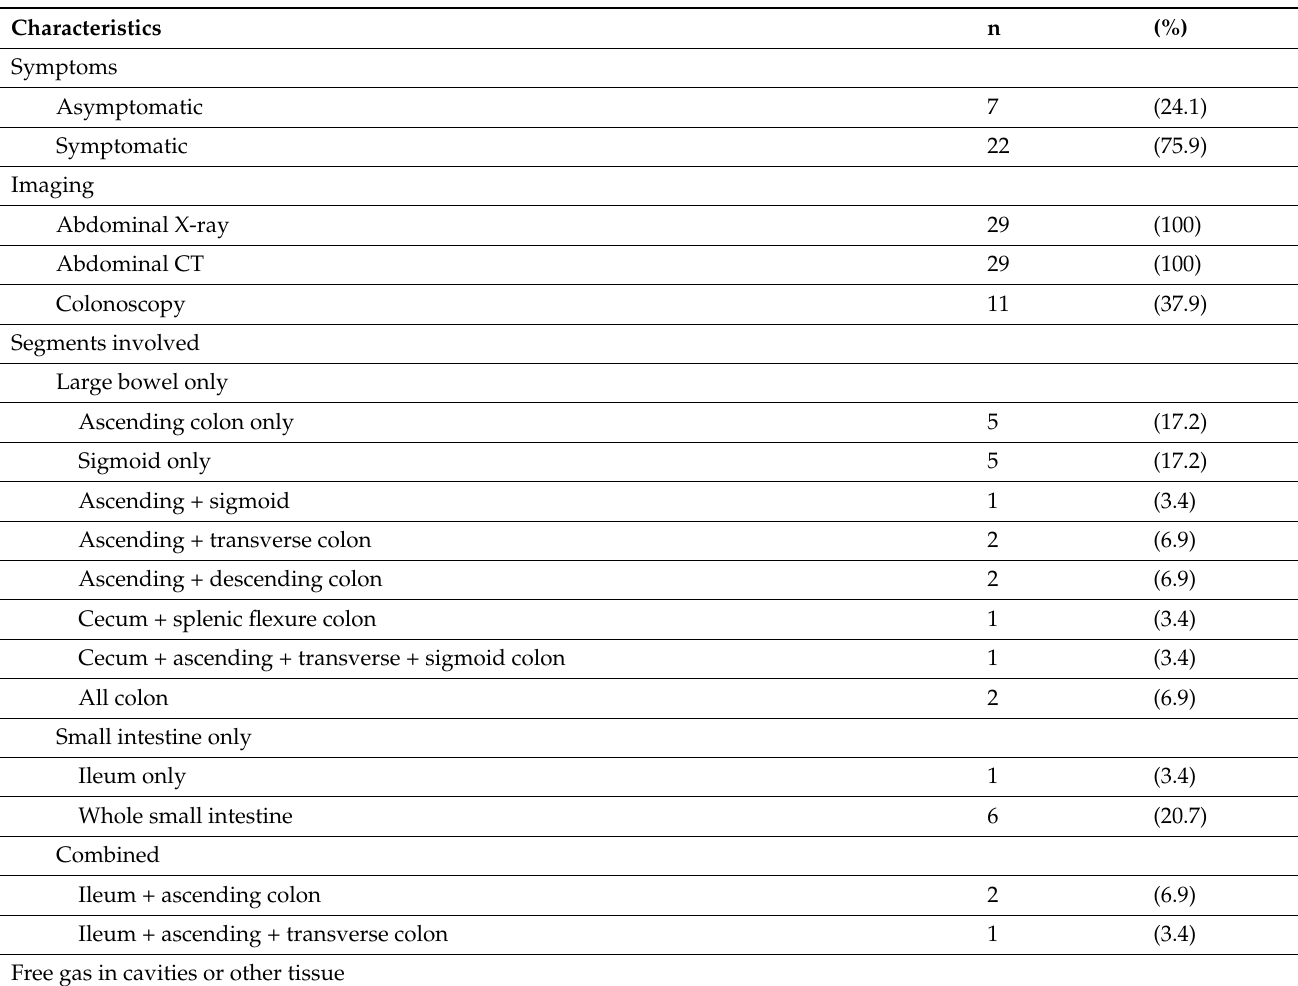
Table 2. Characteristics of